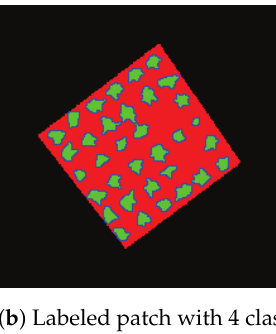
( b ) Labeled patch with 4 classes: (black is background, red is soil, green is plant, and blue is contour).